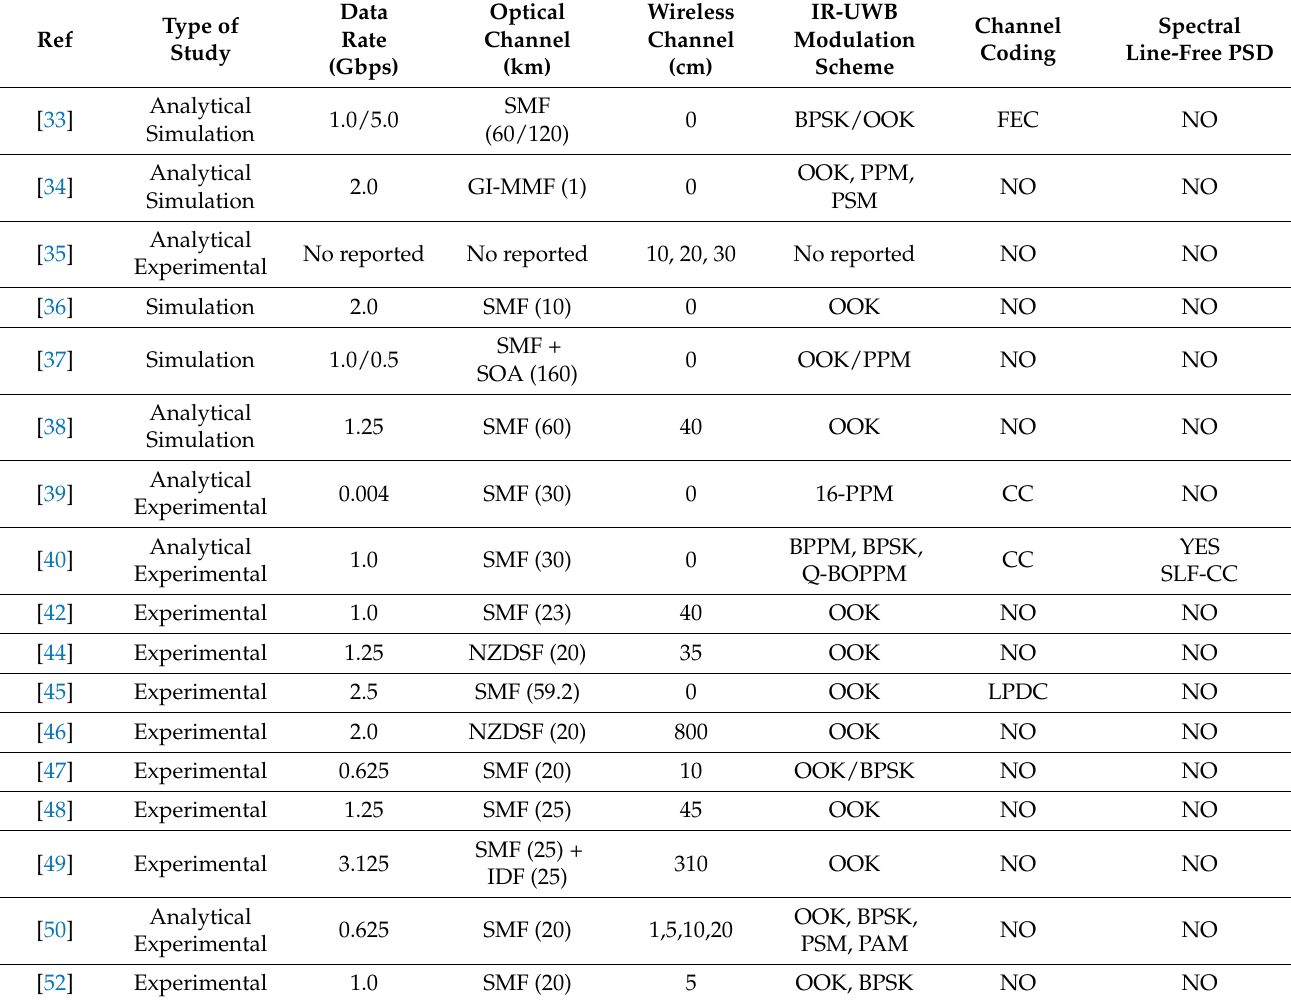
Table 1. Previous art of IR-UWB over fiber